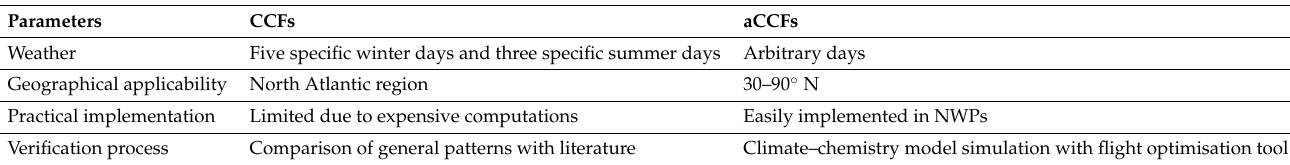
Table 1. Comparison of crucial characteristics of CCFs and aCCFs. “NWPs” stands for numerical weather prediction